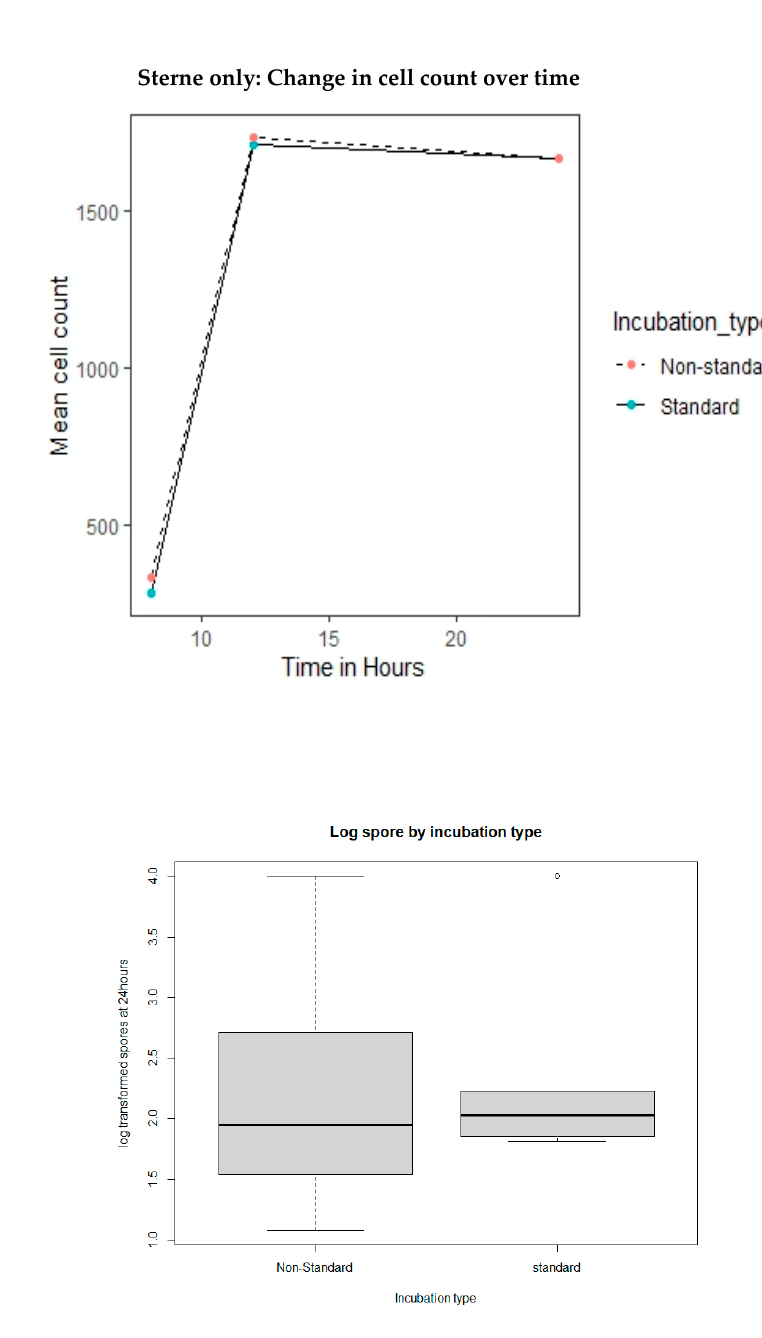
Figure A5A–E: There does not appear to be an e ff ect of incubation type. However, there is a di ff erence between the bacterial types (same pattern but note the di ff erences in scale for Bacillus anthracis DS201579 and Sterne 34F2).